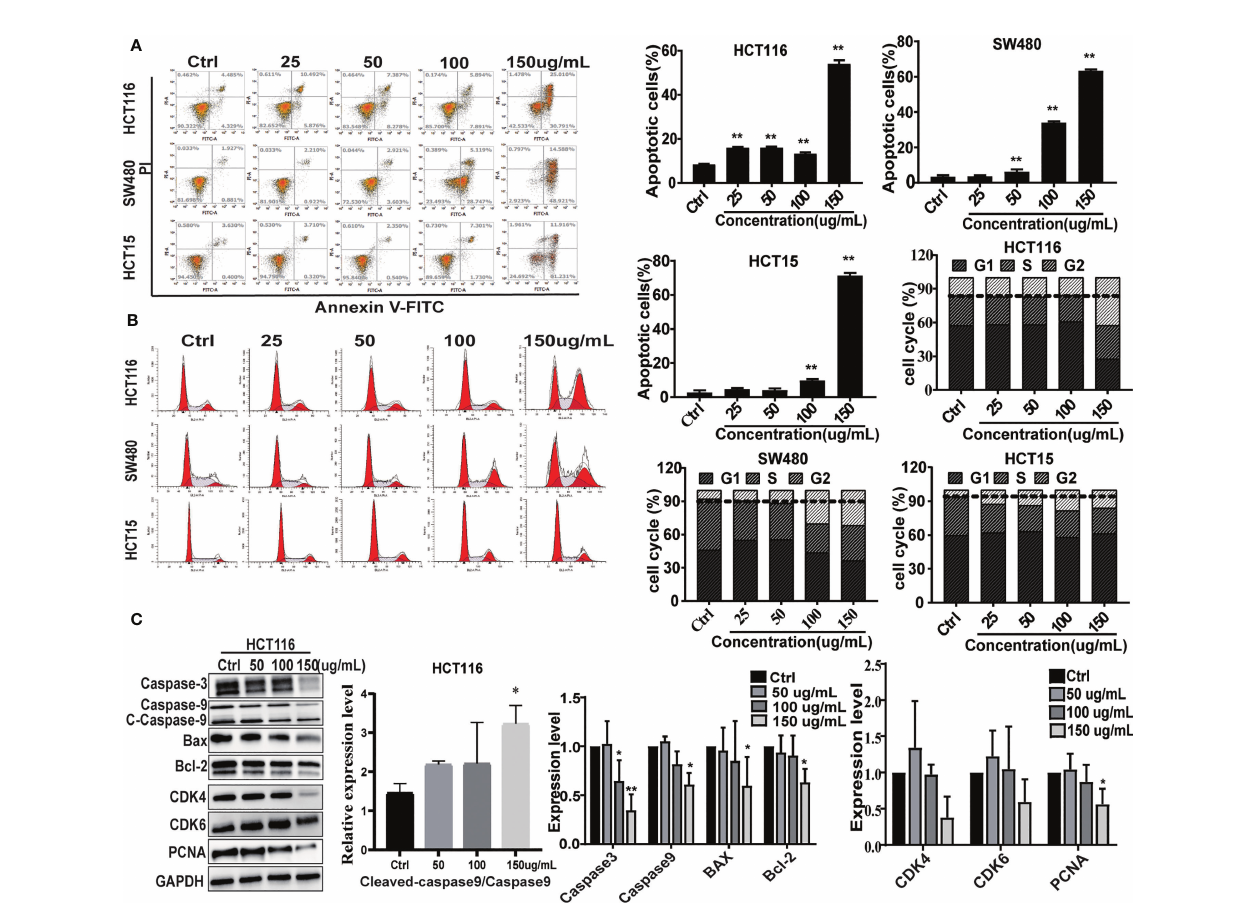
FIGURE 2 | The effect on cell apoptosis and cell cycle. (A) Apoptosis rate induced by CNC extract in cell lines. (B) The cell cycle distribution of cell lines incubated by CNC extract. (C) WB analysis of related proteins in HCT116 after intervention of CNC extract. There were three duplicate samples in each experiment. Data are expressed as mean ± SD. Compared with control group: *p < 0.5, **p <